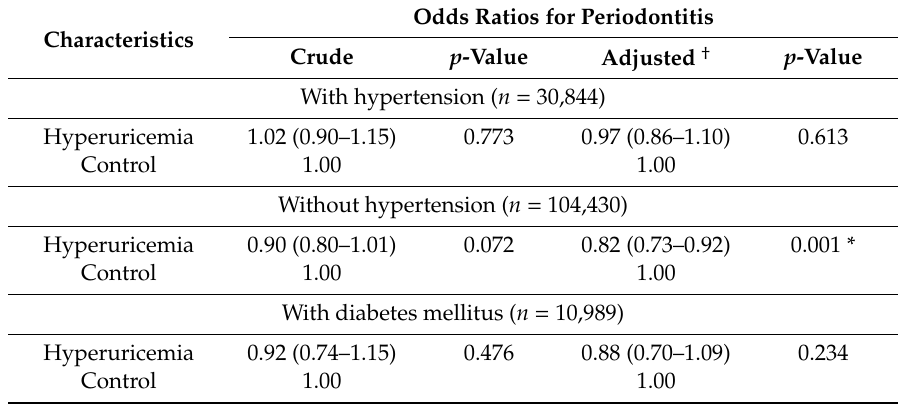
Table 3. Crude and adjusted odds ratios (95% confidence interval) for periodontitis in hyperuricemia and control participants according to their past medical